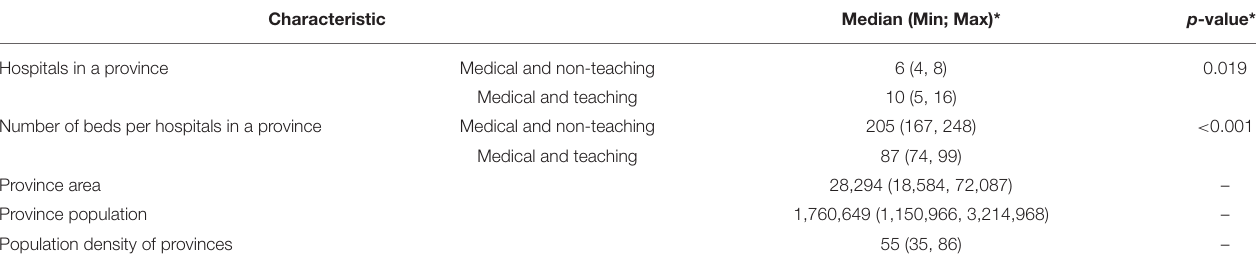
TABLE 3 | Descriptive statistics and comparison of variables between educational and non-educational hospitals.